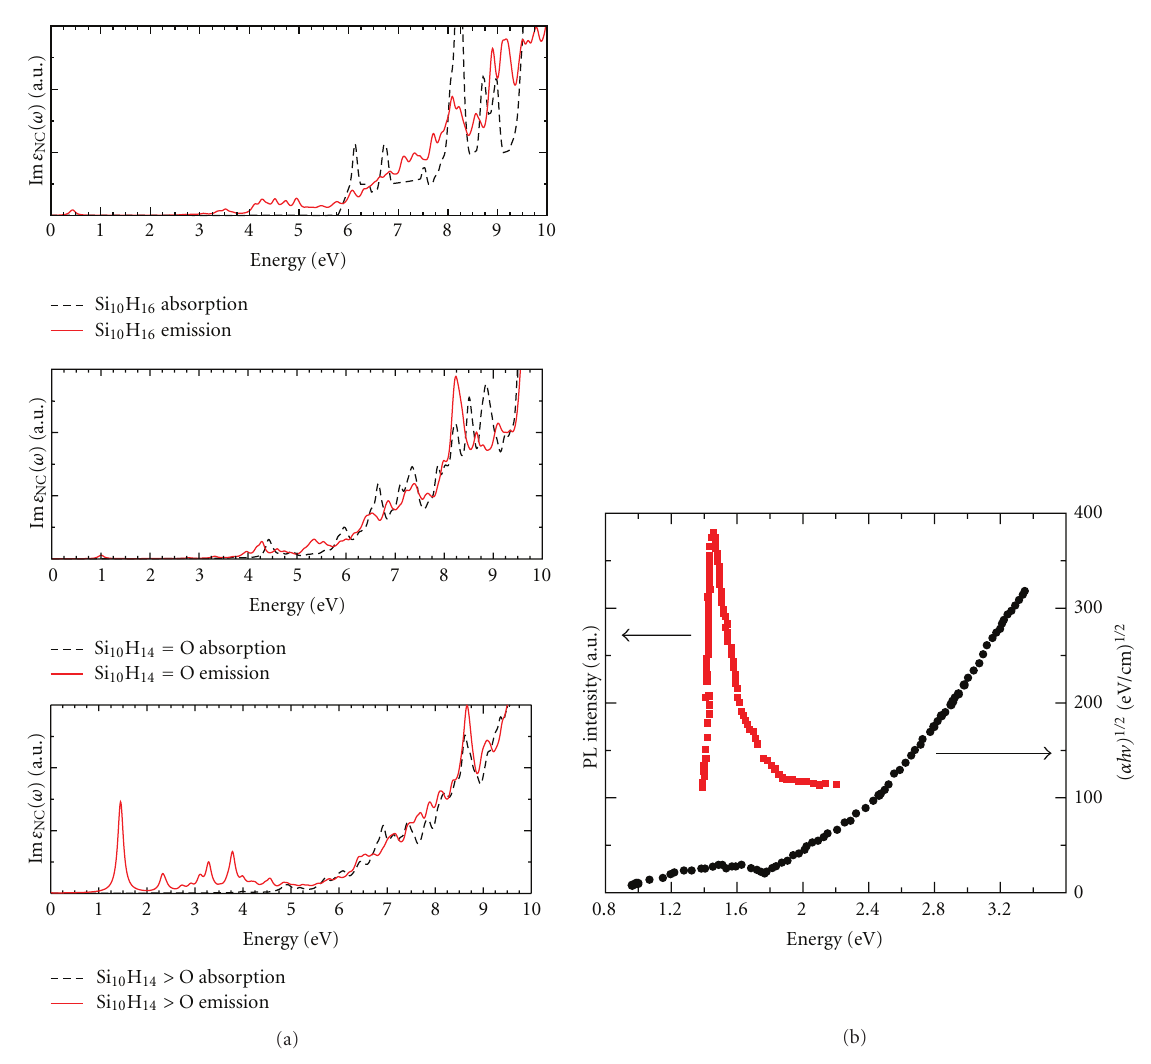
Figure 1: (a) Calculated absorption (dashed line) and emission (solid line) spectra: (from top to bottom) imaginary part of the dielectric function for the Si 10 H 16 nanocrystal, the Si 10 H 14 = O nanocrystal with a double bonded oxygen, and the Si 10 H 14 > O nanocrystal with a bridge bonded oxygen [54]. (b) Experimental results for absorption (black curve on the right) and emission (red curve on the left) by Ma et al.